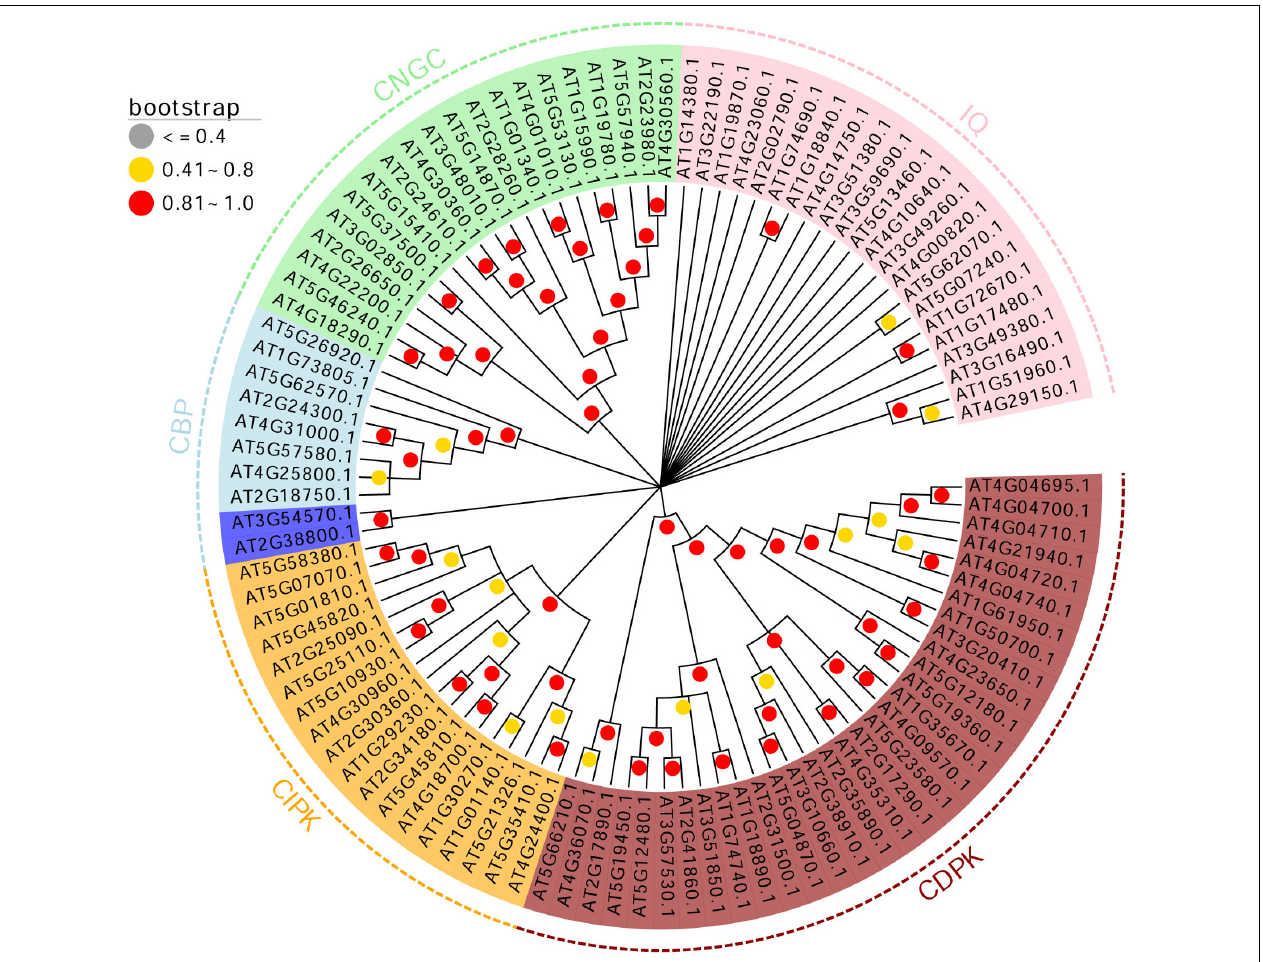
FIGURE 4 | Phylogenetic analysis of the 102 genes in calcium-related gene families. A maximum likelihood phylogenetic tree was constructed based on the 102 genes in calcium-related gene families. The boostrap values (1,000 replicates) are visualized in red (0.81 < bootstrap < 1.0), yellow (0.41 < bootstrap < 0.8) and gray (bootstrap ≤